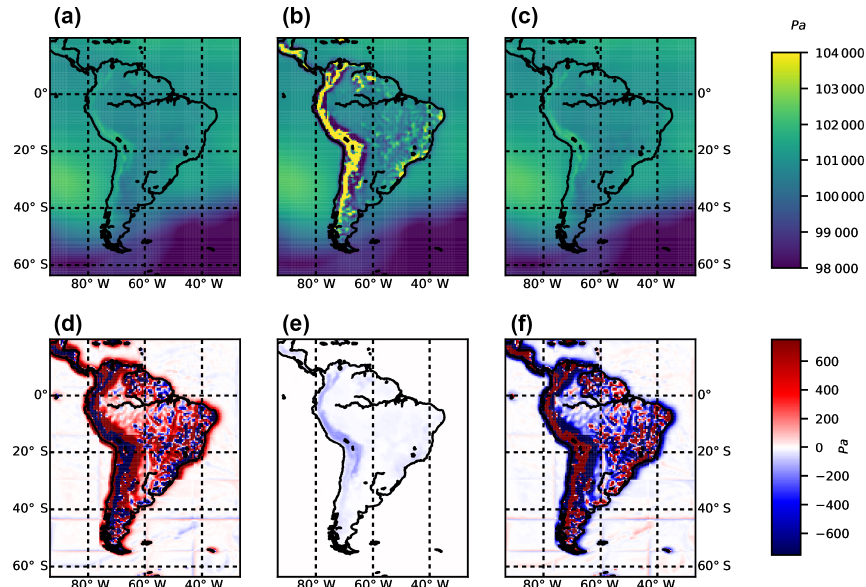
Figure 3. Sea level pressure estimates following the hydrostatic Shuell method at a given time step (psl shuell , a ), ptarget (psl ptarget , b ), and ECMWF (psl ecmwf , c ). Bottom panels show differences among methods psl shuell − psl ptarget (d) , psl shuell − psl ecmwf (e) , and psl ptarget − psl ecmwf (f) .